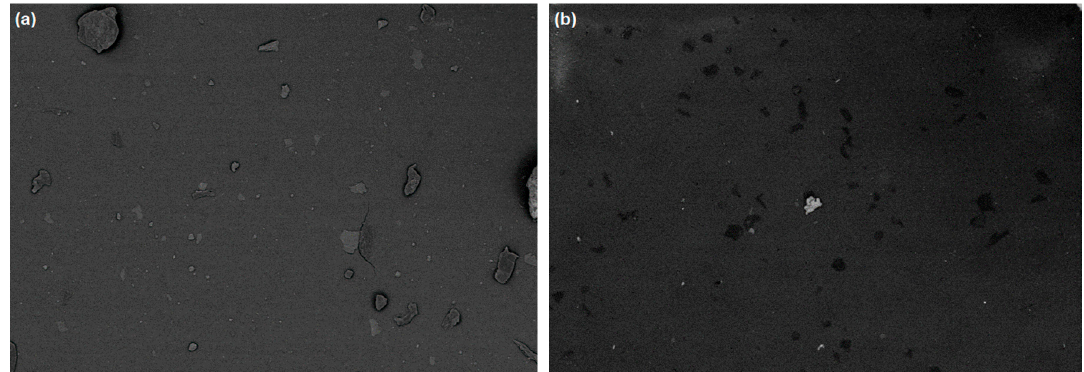
Figure 6. SEM images of the surface (height = 0 mm) of the composites A ( a ) and B ( b ). 150